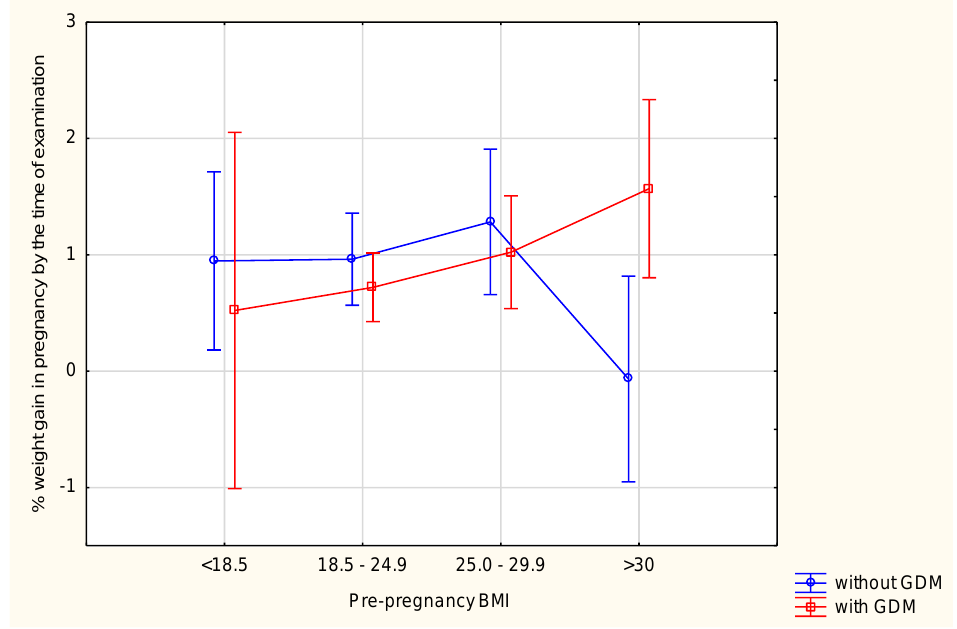
Figure 7. The effect of a pre-pregnancy BMI on the percentage of GWG by the time of examination.